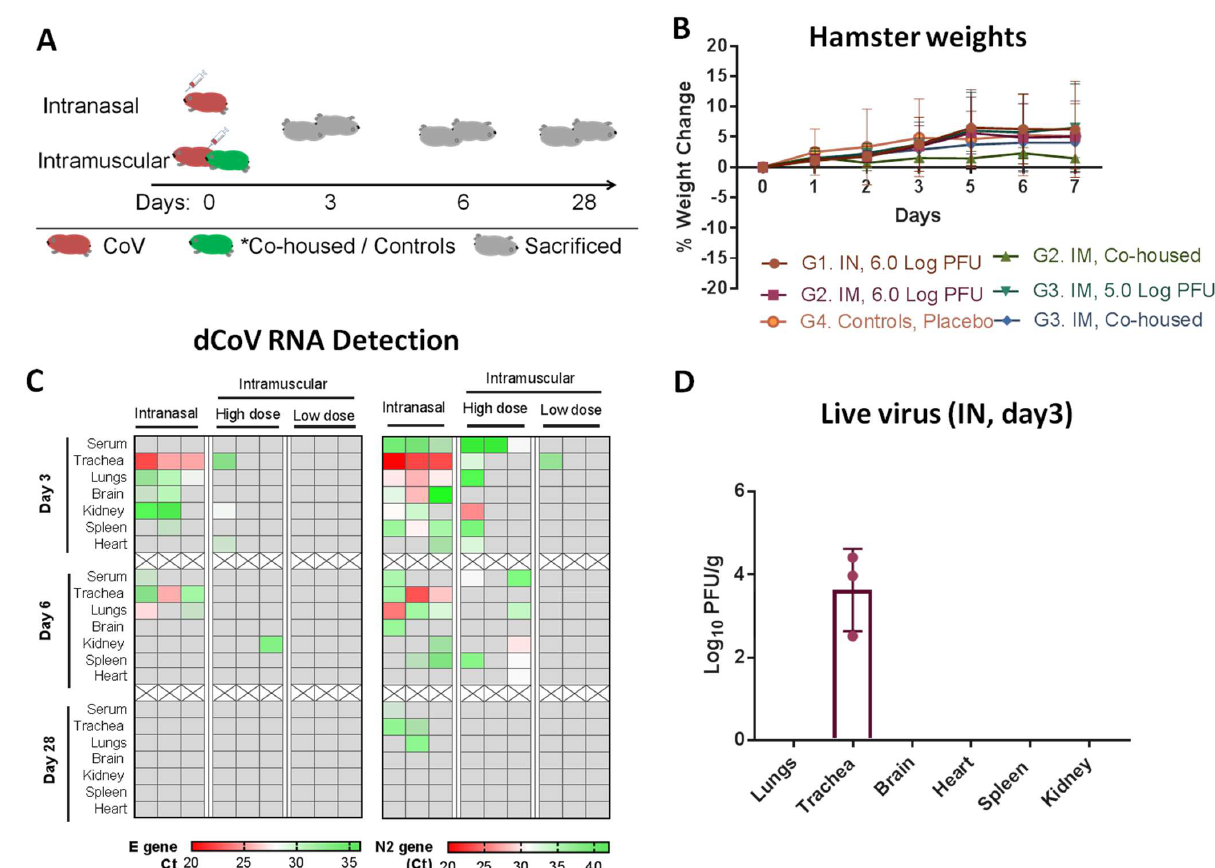
Figure 2. Safety and Biodistribution of CoV in Hamsters ( A ) Schematic representation of the experi- mental design. Hamsters ( n = 9) per group, 4 groups were administered dCoV either via IN route (G1) or IM (G2—6.0 log 10 PFU/animal (high dose); G3—5.0 Log 10 PFU/animal (low dose)) (red color). Control animals (green) consist of co-housed animals (*), 2 hamsters per cage in IM groups G2 and G3) or negative controls (G4) that received placebo. Three animals per group were sacrificed on day 3, day 6 and day 28 post administration to study viral load. ( B ) Animals’ weights (gram) monitored during experimental period. ( C ) Heat map from each group representing viral RNA (E and N2 gene) detected using real time PCR. Grey cells represent no viral RNA detected (cut-off Ct value of E gene having high specificity is equivalent to detection limit of 0.01 PFU and N2 gene with high sensitivity had a detection limit equivalent 0.001 PFU). ( D ) Presence of live replicating virus in trachea detected on day 3 post IN administration of dCoV represented as a dot per animal, bar with Mean and SD ( n = 3) is